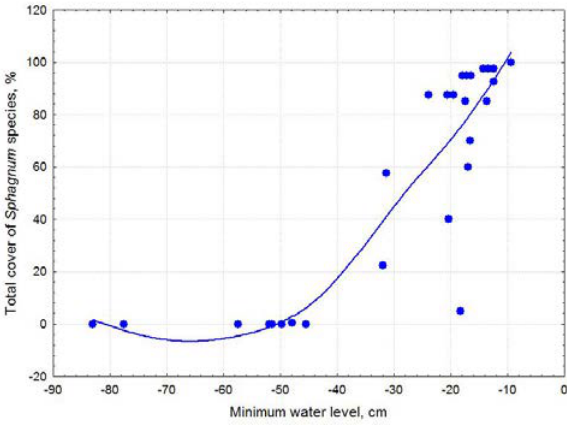
Figure 5. Relationship between the total cover of Sphagnum species and minimum water level.